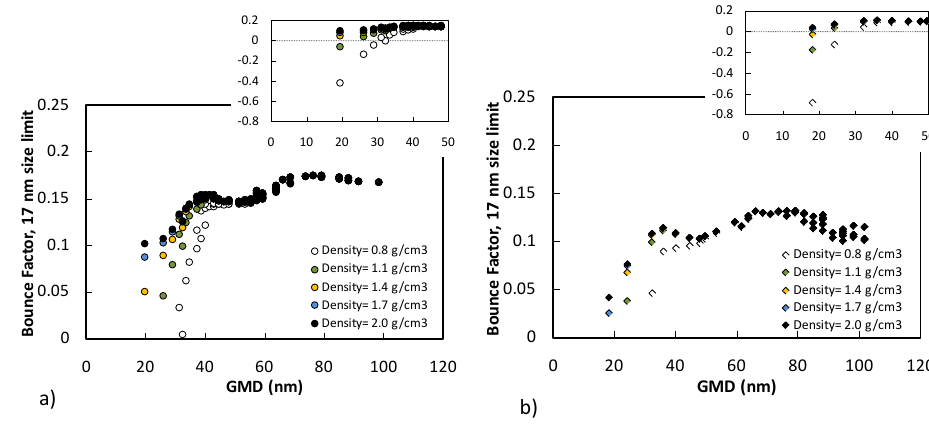
Fig. 2. Calculated bounce factors for the 17nm size limit measured for (a) O 3 initiated oxidation in absence of SO 2 and (b) OH dominated oxidation in presence of SO 2 . Density values varying from 0.8gcm − 3 to 2gcm − 3 were used in calculations. Insets in the upper right corners of (a) and (b) show details in bounce factor values for the smallest particles.